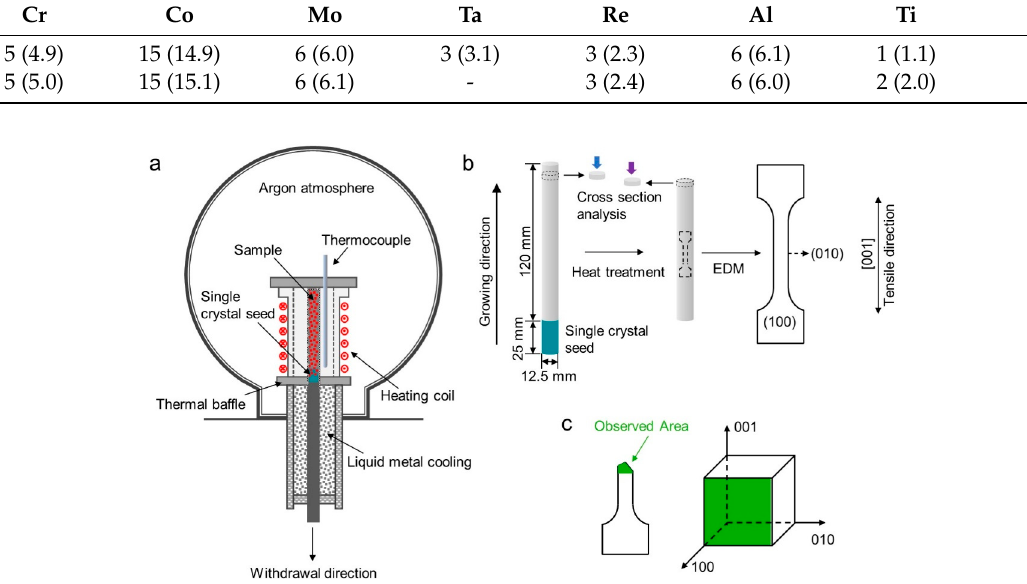
Figure 1. Schematic diagram showing SX growth and sample preparation procedures. ( a ) SX growth in a Bridgeman furnace; ( b ) The preparation and the orientation of tensile samples; ( c ) Observation position for deformed microstructure. The viewing direction is normal to (100)